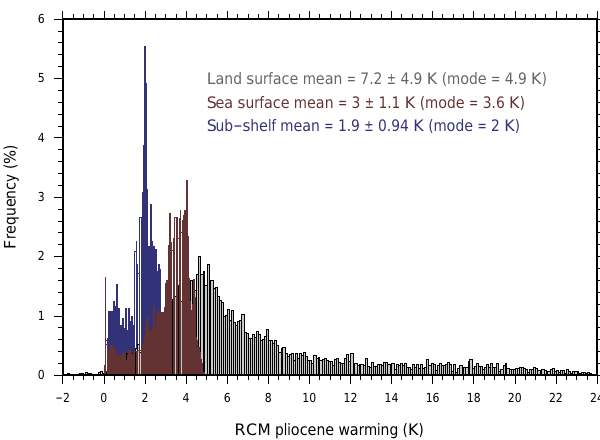
Figure 4. Histogram representation on the anomaly data shown in Fig. 3. Biases used in certain simulations are additional to the warm- ing values shown here. Note the very long tail that skews the mean value of modelled land surface warming, indicating that the modal value might be most representative of the continent as a whole. Sea- surface temperature anomalies are also higher in the open ocean than those of a subset representing ocean areas where present-day ice shelves